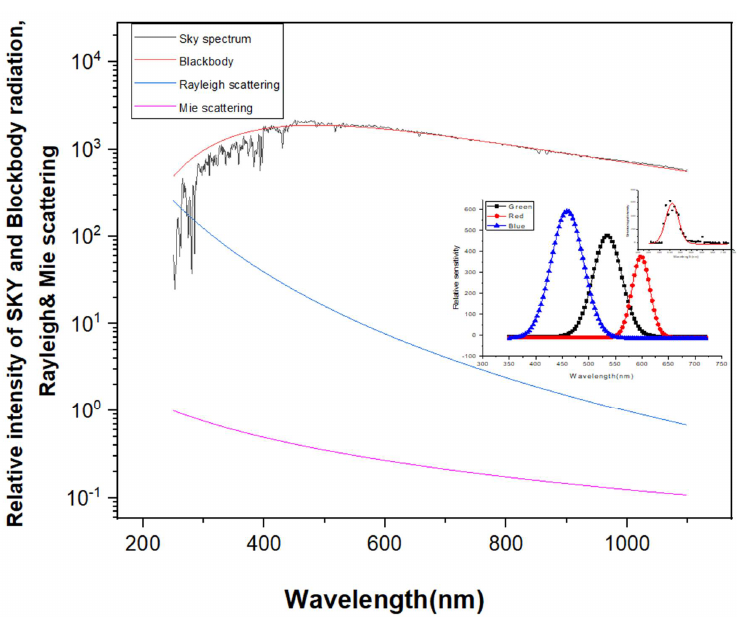
Figure 2. Wavelength-dependent parameters used to calculate the effective wavelengths.